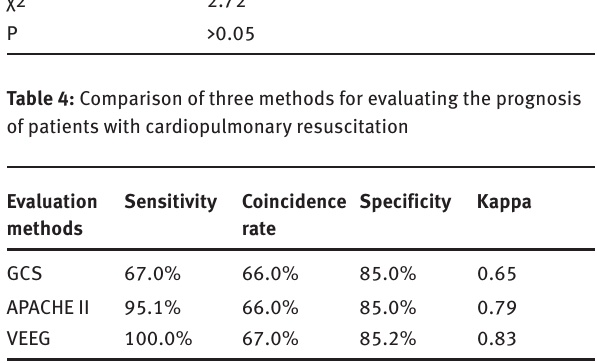
Figure 3: Comparison of the mortality rate between the three evalu- ating model Evaluation methods